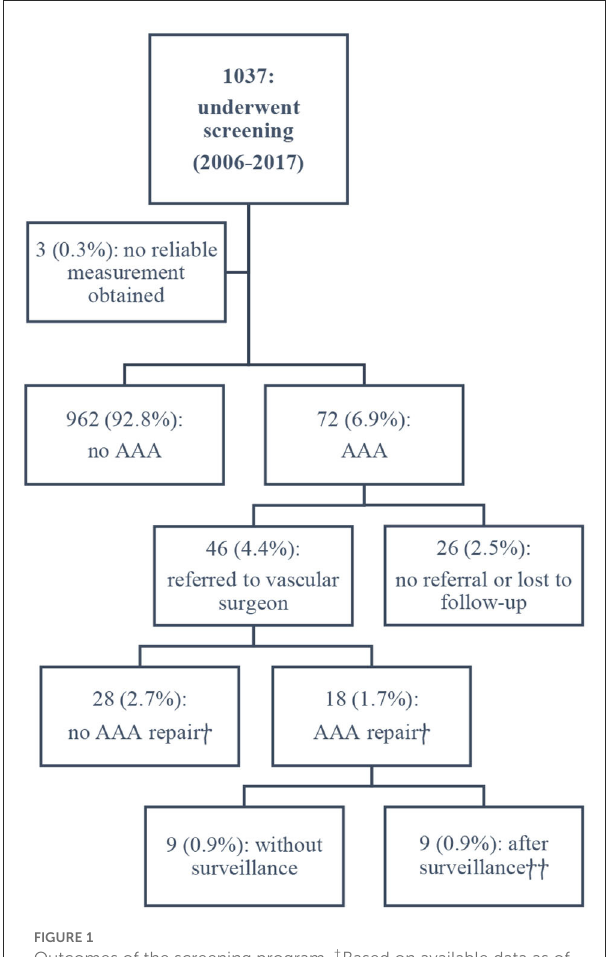
FIGURE1 Outcomes of the screening program. † Based on available data as of August 2018. †† Median surveillance period: 40